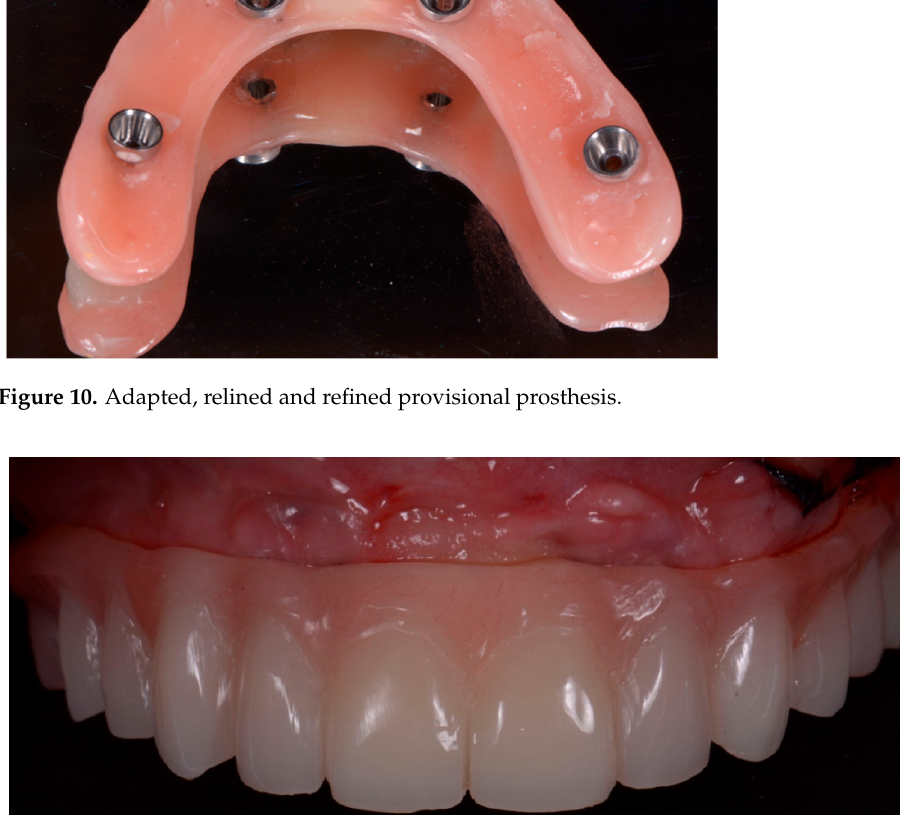
Figure 11. Provisional prosthesis screwed in the patient’s mouth.